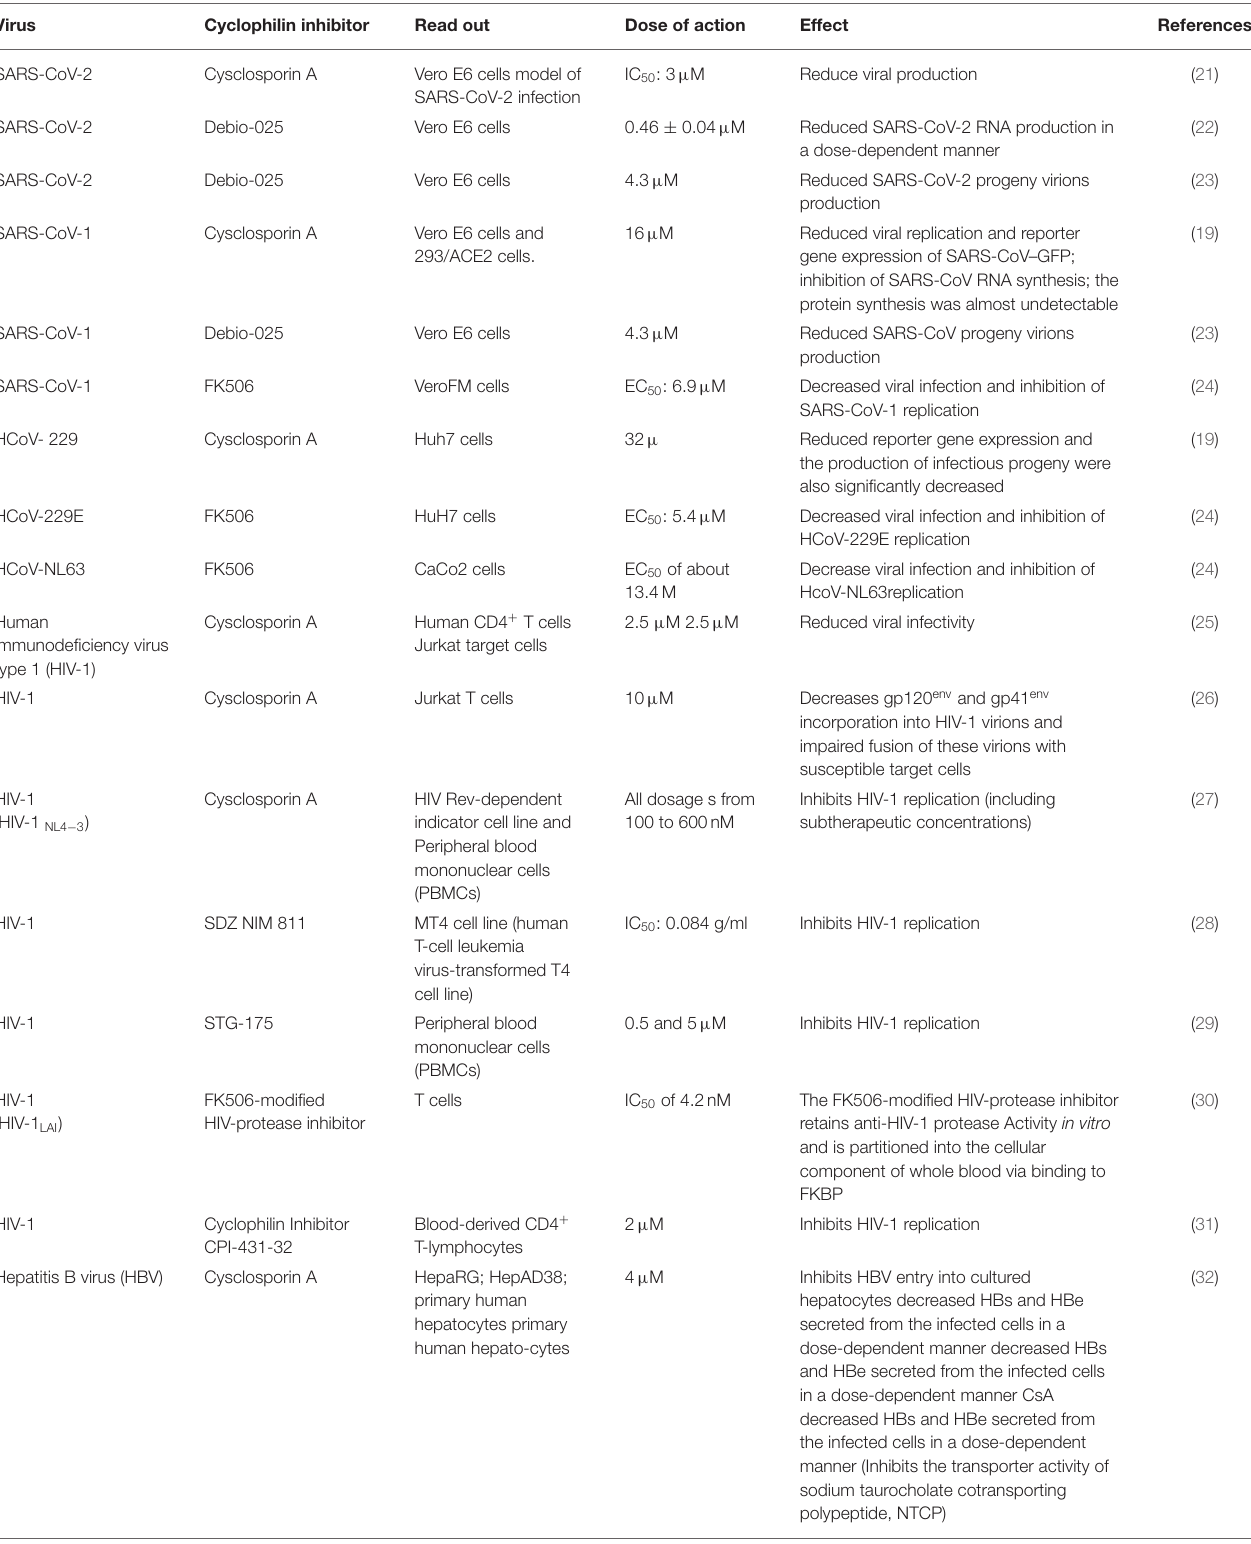
TABLE 1 | In vitro activity of cyclosporine A against